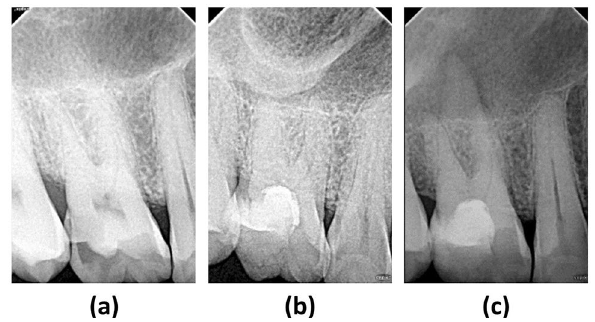
Figure 6. The right maxillary first molar was diagnosed with irreversible pulpitis and underwent a full pulpotomy. ( a ) Pre-operative radiographic examination showing deep caries invading the pulp chamber, with a periapical index (PAI) score of 1. ( b ) 3-month follow-up showing no abnormality. ( c ) Periapical rarefaction was observed at the 6-month follow-up, with a PAI score of 2 in the buccal roots and 3 in the palatal